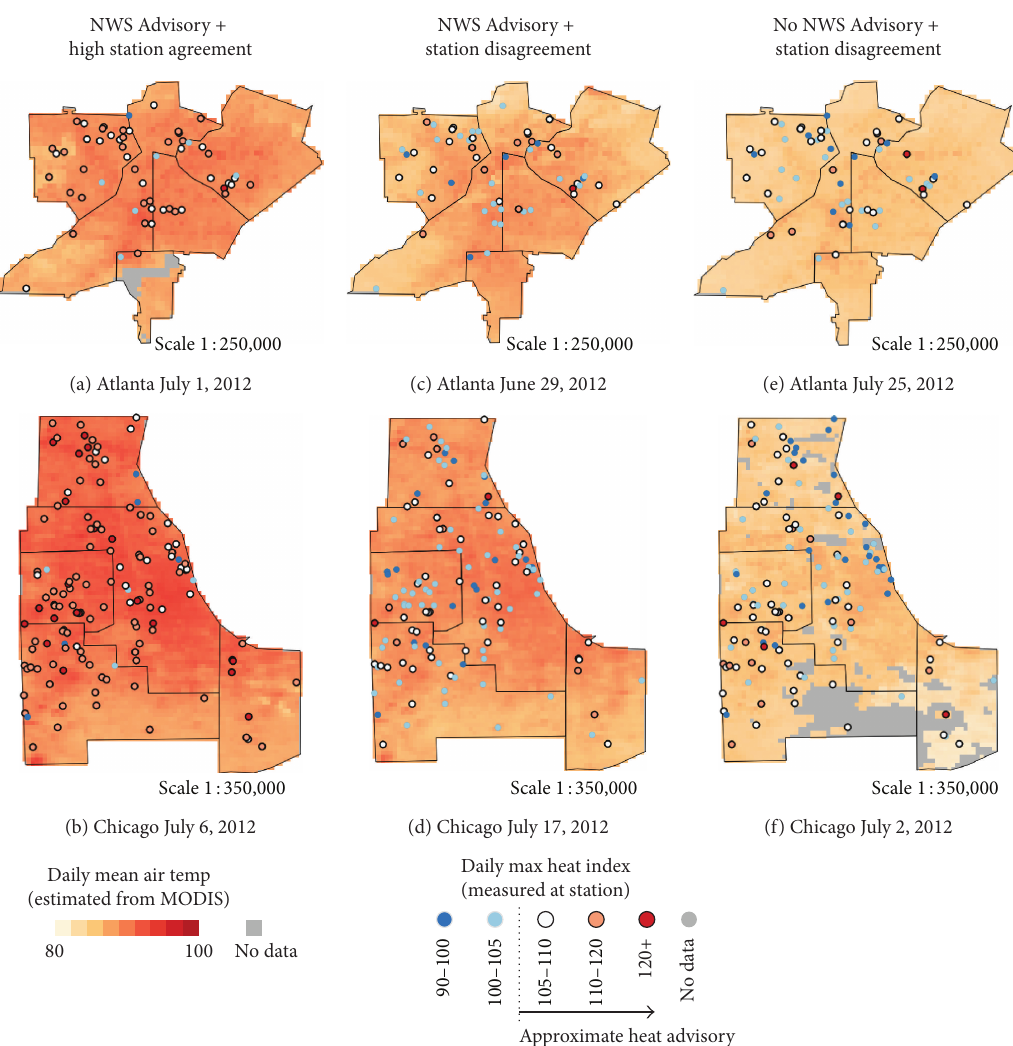
Figure 4: Air temperatures modeled from Land Surface Temperature data from MODIS satellites are shown with station-measured heat index data with varying levels of agreement between NWS Heat Advisory status and station